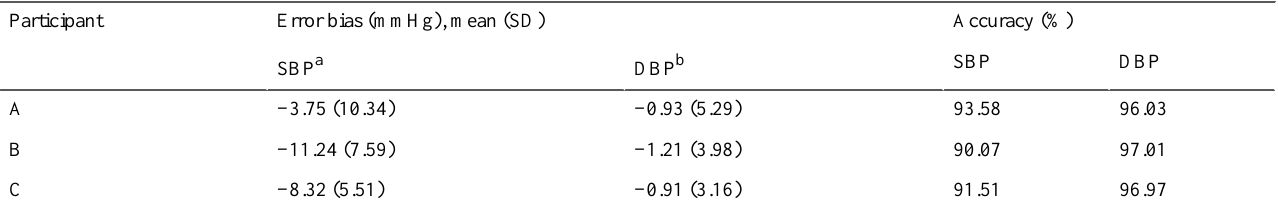
Table 3. Assessment of blood pressure prediction for each participant.